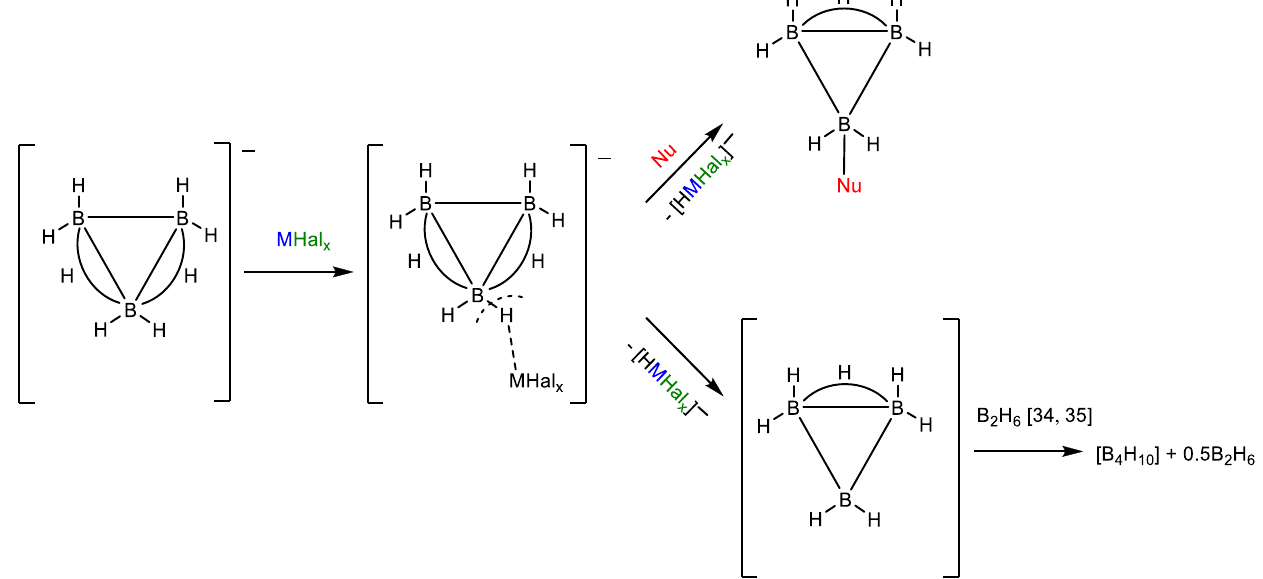
Scheme 3. Possible scheme of the substitution reaction in the octahydrotriborate